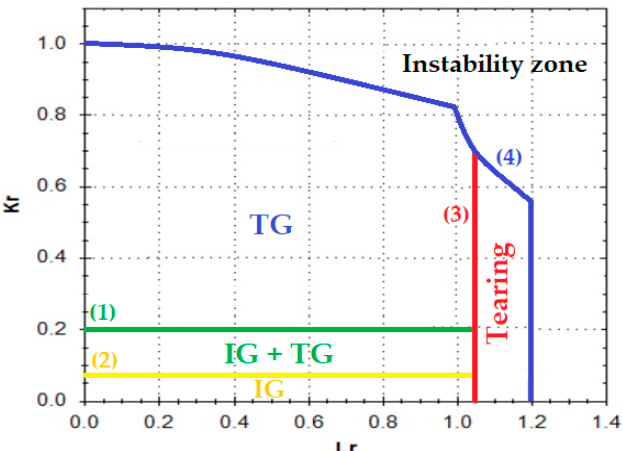
Figure 5. Zones for di ff erent hydrogen induced cracking (HIC) mechanisms in a FAD diagram in the original model.